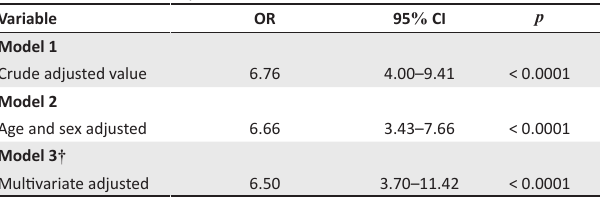
TABLE 3: Results of the unadjusted and adjusted logistic regression to assess the relation between depression and not using condoms amongst people living with human immunodeficiency virus.